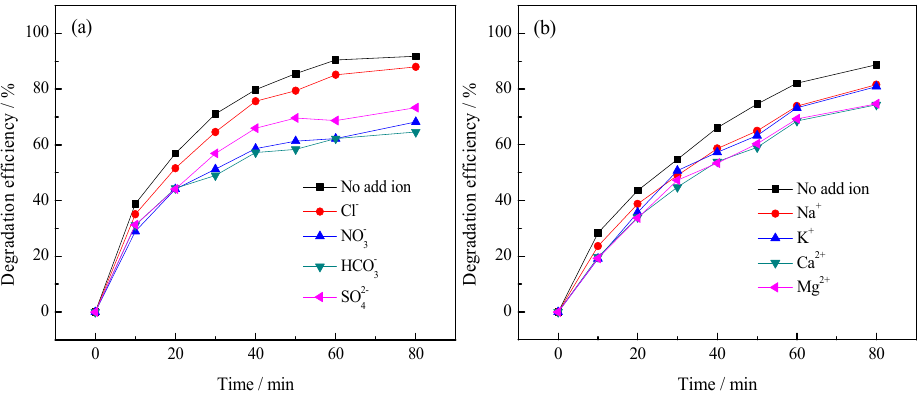
Figure 6. Effect of inorganic anions ( a ) and cations ( b ) on the degradation of benzohydroxamic acid by Yb/TiO 2 . The benzohydroxamic acid (BHA) concentration was 30 mg/L, the catalyst dosage was 0.3 g/L, and the concentrations of cation ions and anion ions were 5 mmol/L.